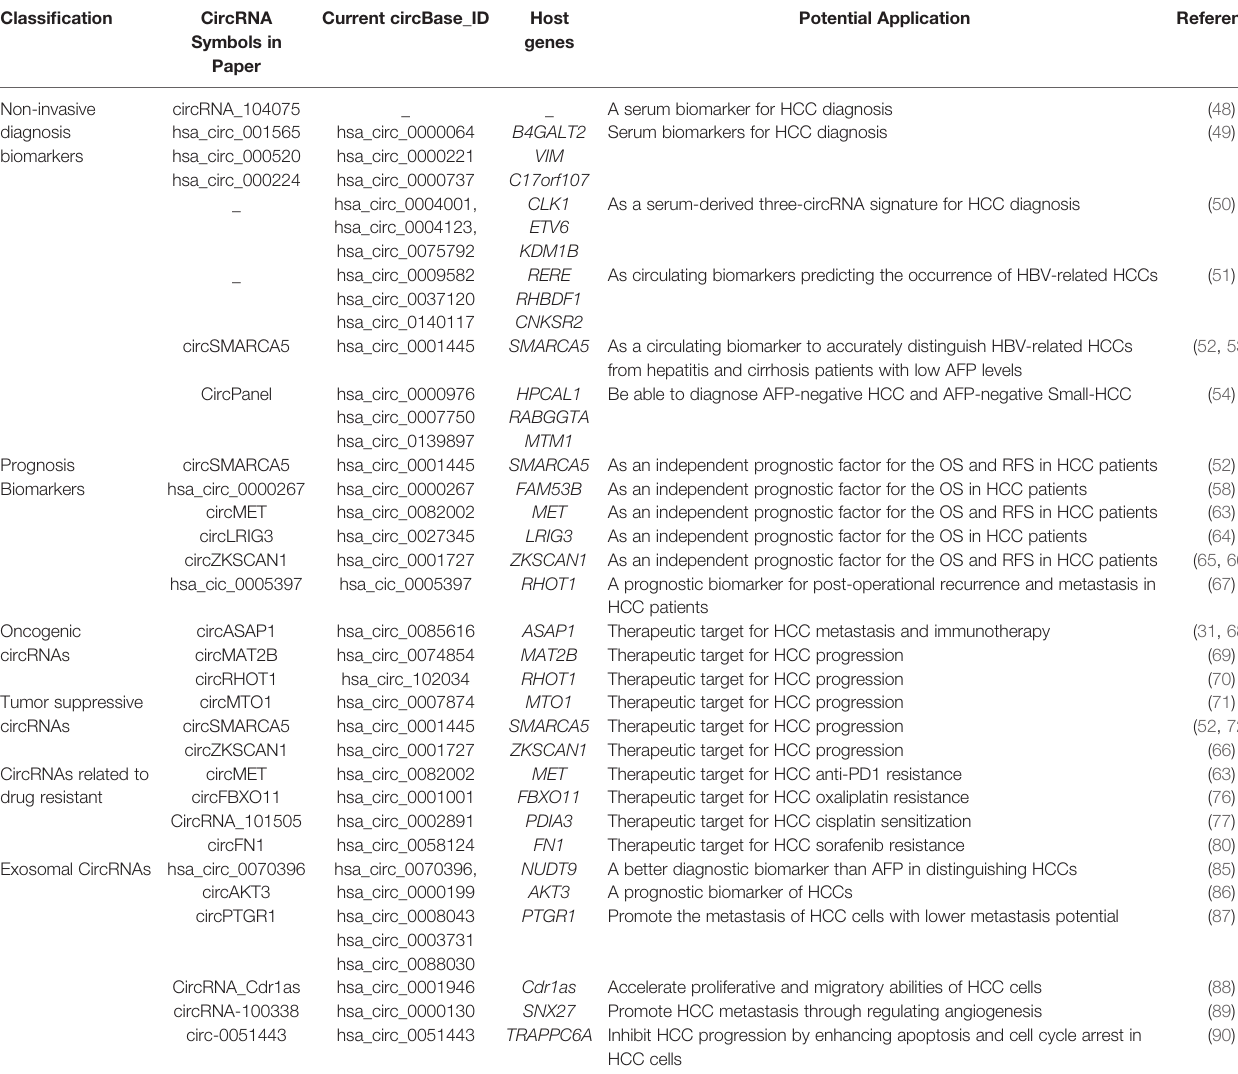
TABLE 1 | Summary of mentioned circRNAs with diagnosis, prognosis and therapeutic potential in